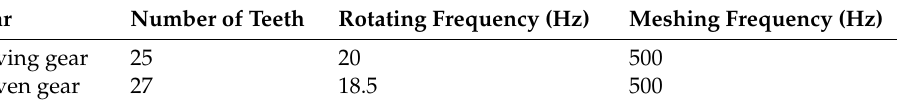
Table 4. Specification of the third-speed gears.